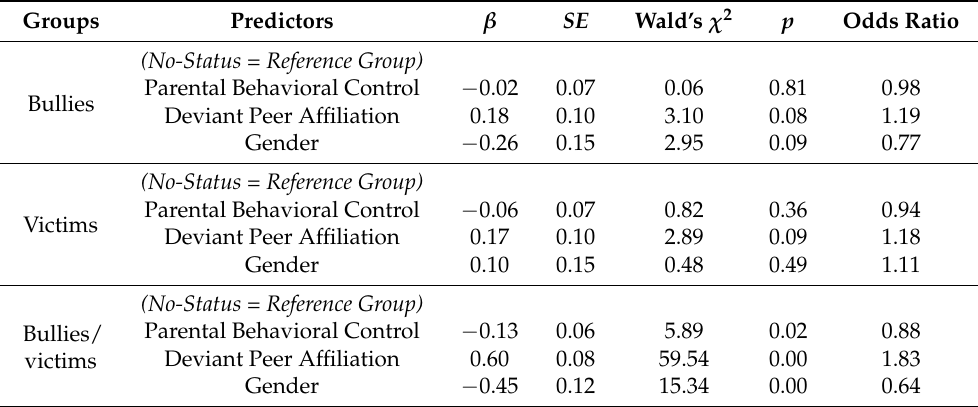
Table 4. Logistic regression analyses predicting bullying and victimization grouping.